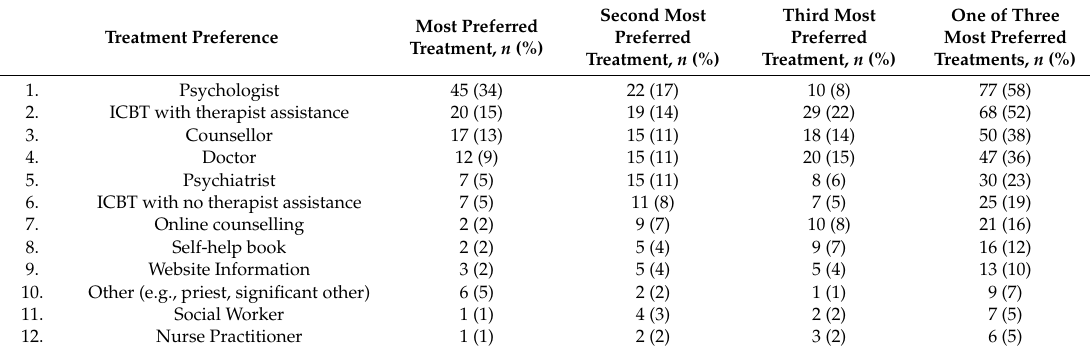
Table 2. Mental health treatment preferences among public safety personnel. Most Preferred Treatment Preference Treatment, n (%)